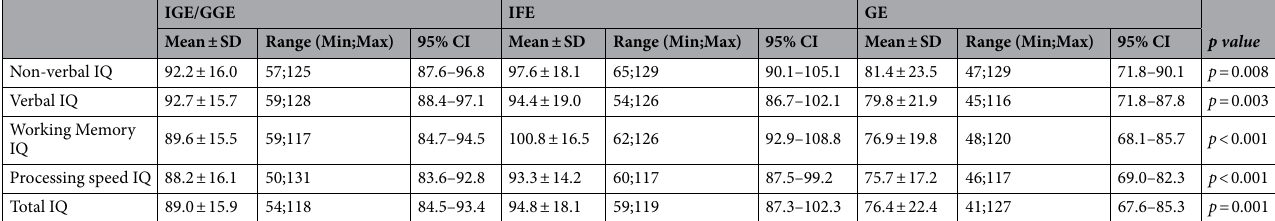
Table 3. Cognitive performance across groups. Intergroup differences are considered significant at p ≤ 0.05. IQ, intelligence quotient; IGE/GGE, idiopathic/genetic generalized epilepsy; IFE, idiopathic focal epilepsy; GE, genetic epilepsy; CI, confidence interval; SD, standard deviation; Min, minimum; Max, maximum.